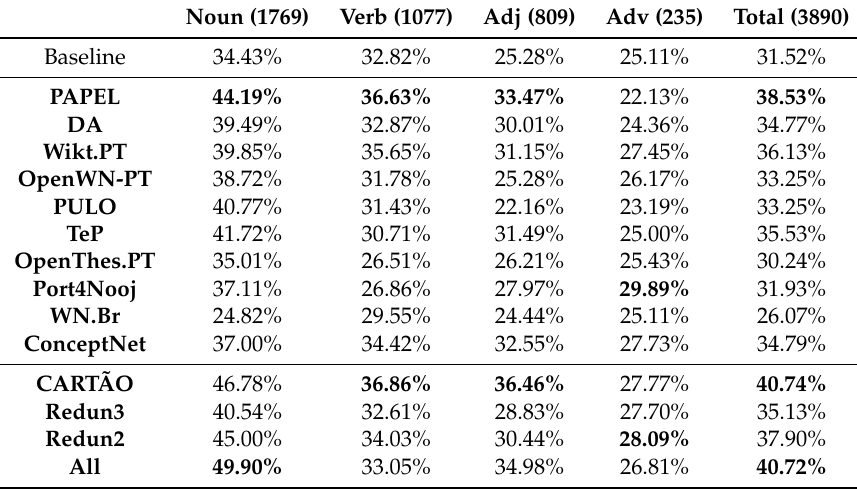
Table 15. Accuracy for answering cloze questions.